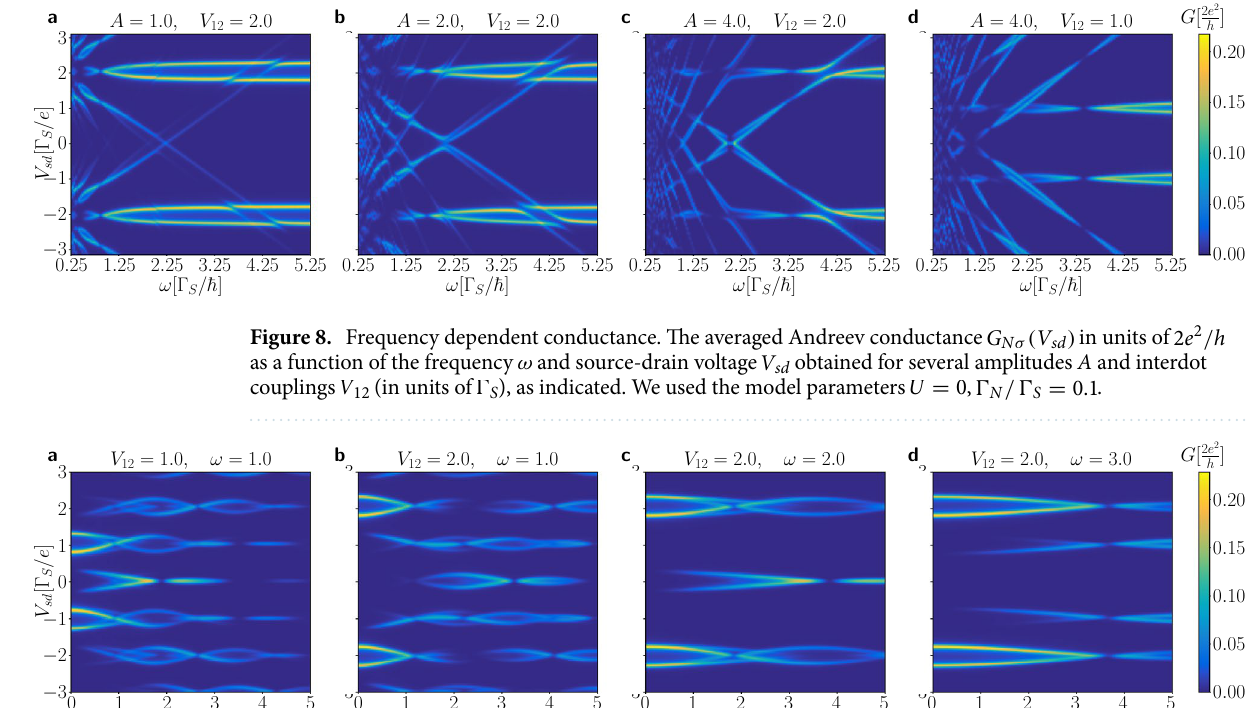
Figure 9. Amplitude dependent conductance. Variation of the averaged conductance G N σ ( V sd ) in units of 2 e 2 / h against the amplitude A of the oscillating levels and source-drain voltage V couplings V 12 and frequencies ω (in units of Ŵ S ), as indicated. Calculations are done for U